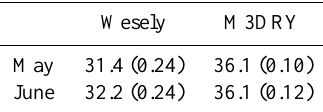
Table 3. Surface ozone concentration (ppbv) and ozone dry deposi- tion velocity (ms − 1 , value in parentheses) in May and June 2004.